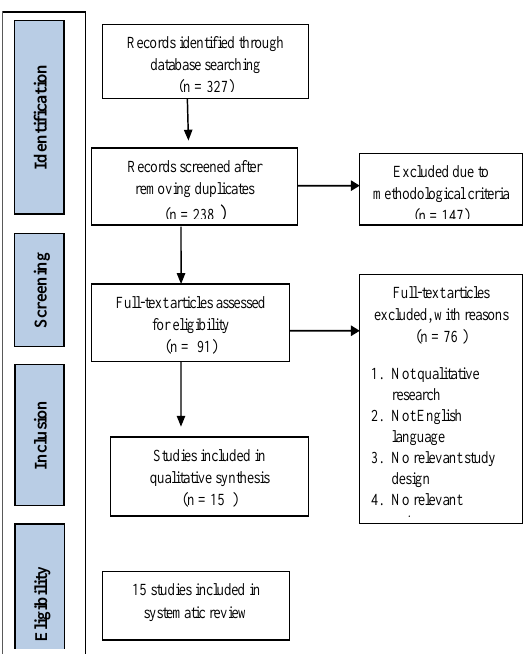
Figure 1: Flowchart of the study